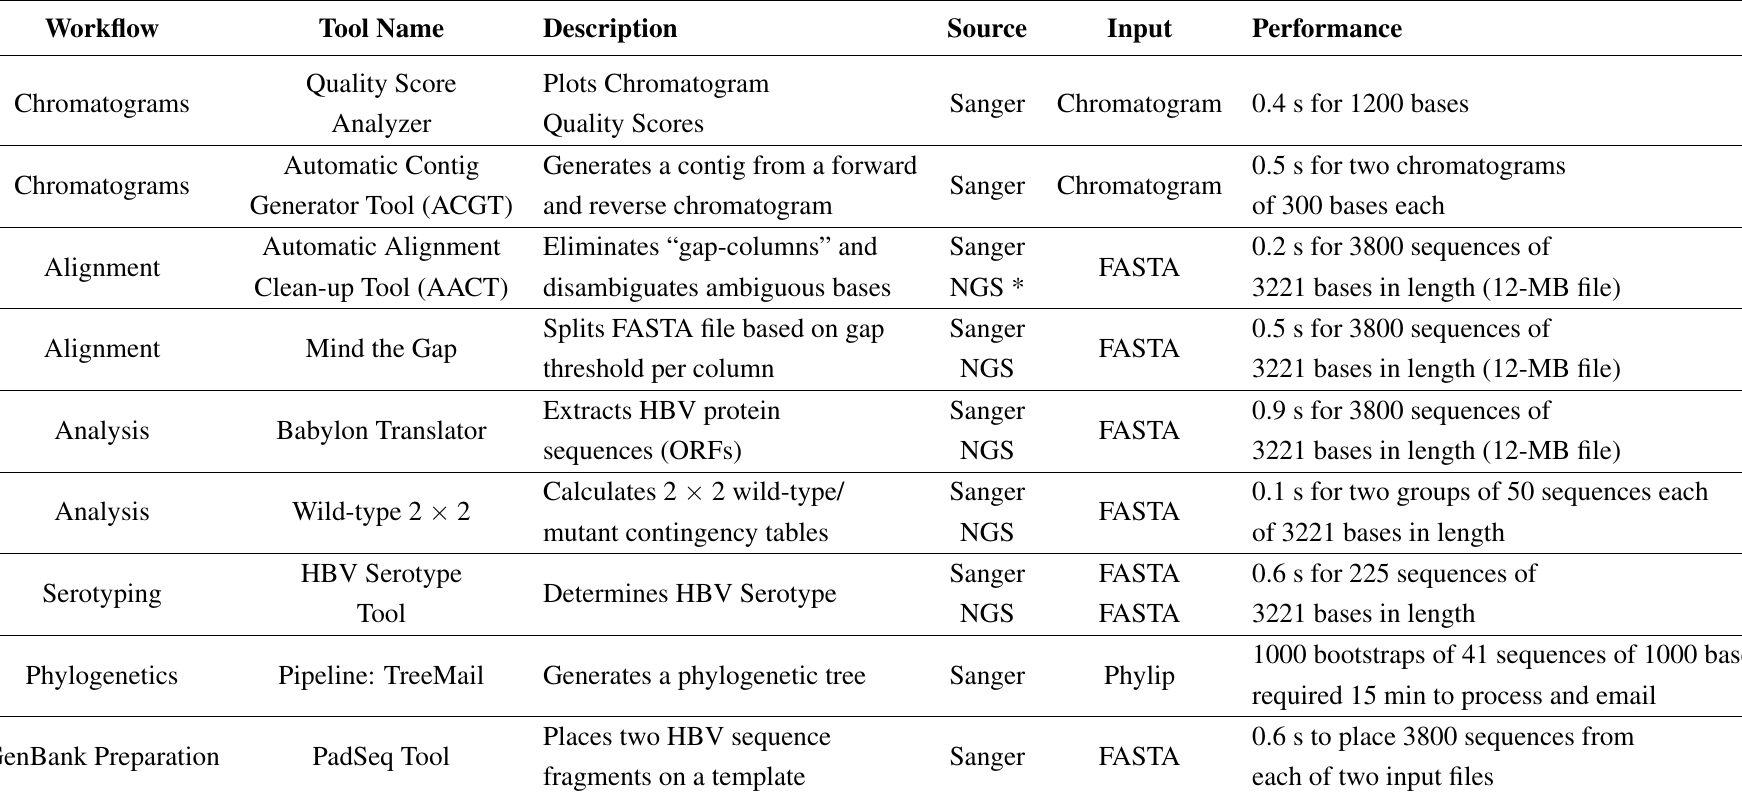
Table 1. Online tools developed and the workflow process for which each would be